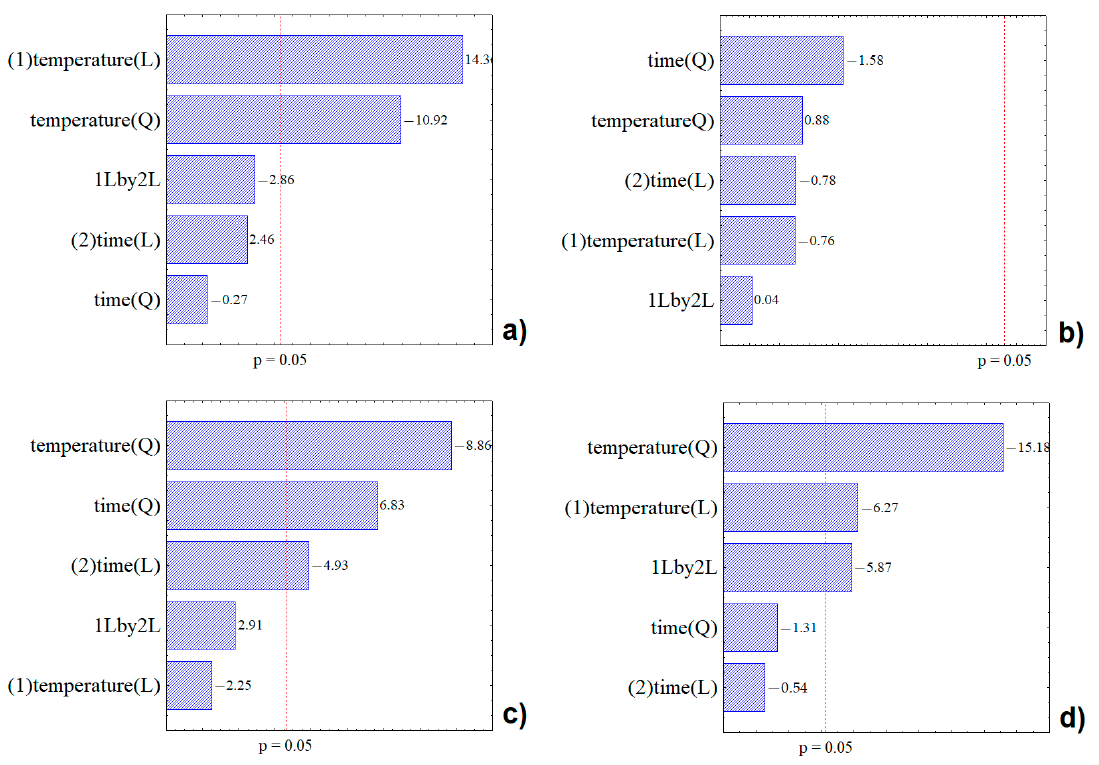
Figure 1. Pareto diagram of the estimated effects on TP ( a ), AA ( b ), TA ( c ), and C-3-G ( d ).